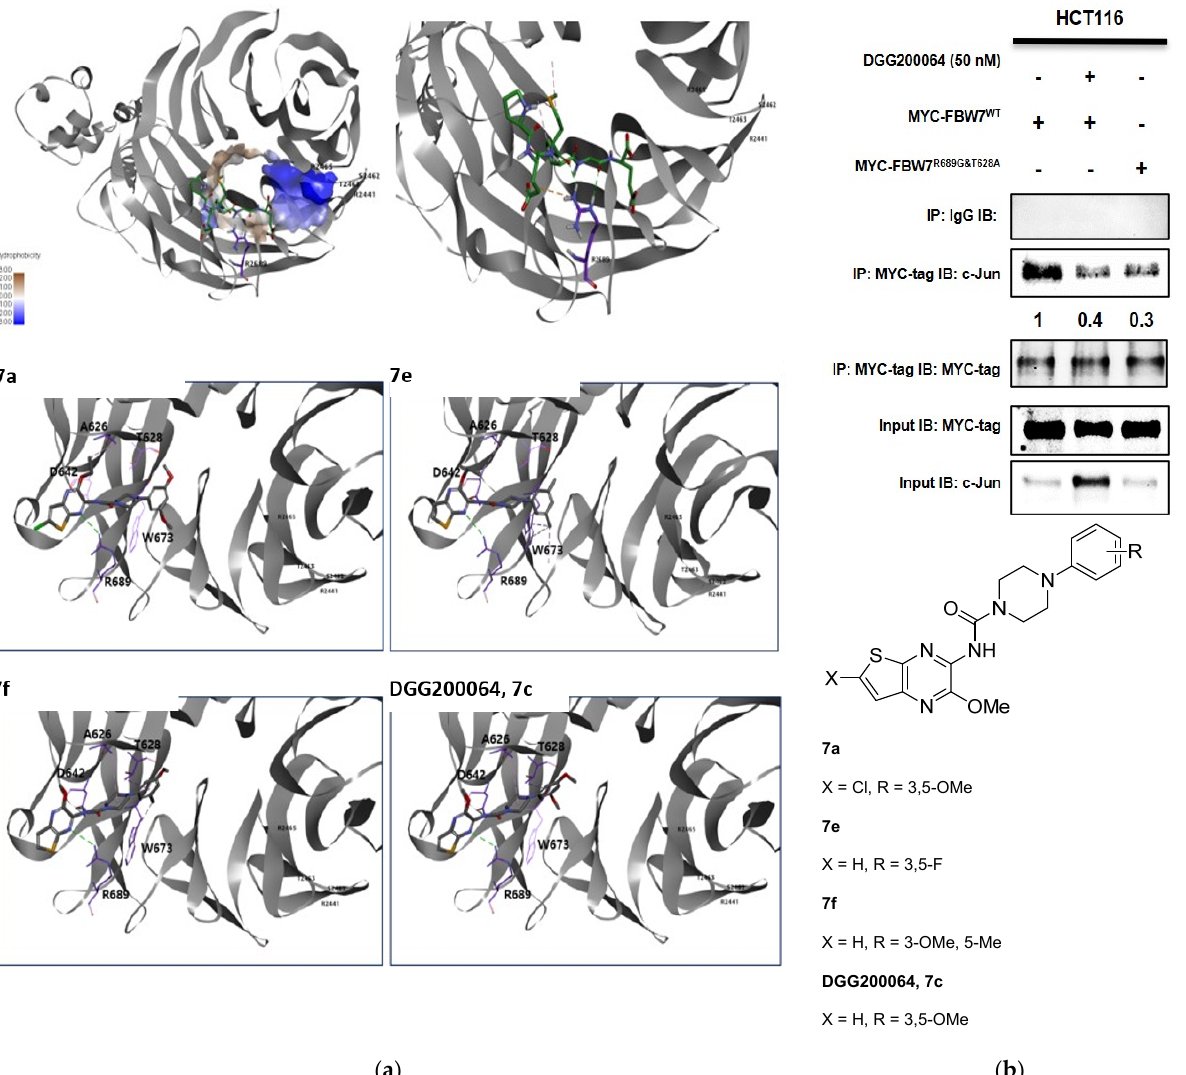
Figure 5. Identification of the interaction inhibition site between FBXW7 and c-Jun: ( a ) Docking modes and interactions of c-Jun, 7a , 7e , 7f, and DGG200064 at the binding site of FBXW7. Electrostatic, hydrogen bond, alkyl, and pi-sigma interaction are displayed as orange, green, pink, and purple dashed lines, respectively; ( b ) HCT116 cells transfected with MYC-FBXW7 WT , MYC-FBXW7 R689G&T628A for 24 h, and then treated with DGG200064 for 6 h. The cell extracts were immunoprecipitated with an MYC-tag antibody and subjected to immunoblotting with antibodies to c-Jun and Myc-tag. Docking results showed that highly potent compounds, 7f (GI 50 = 0.0019 µ M) and DGG200064 (GI 50 = 0.012 µ M), interacted with T628 in addition to R689. Compounds with low potency such as 7a (GI 50 ≥ 0.1 µ M) and 7e (GI 50 ≥ 0.1 µ M) interacted with R689